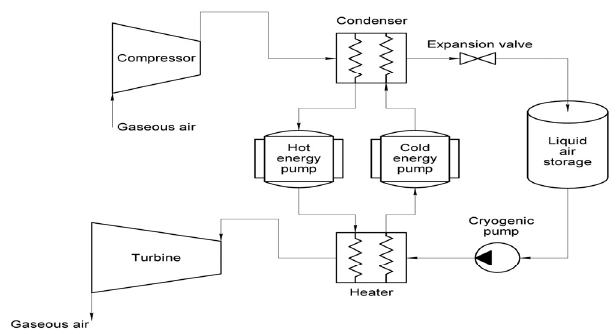
Figure 20. Systems with adiabatic CAES.